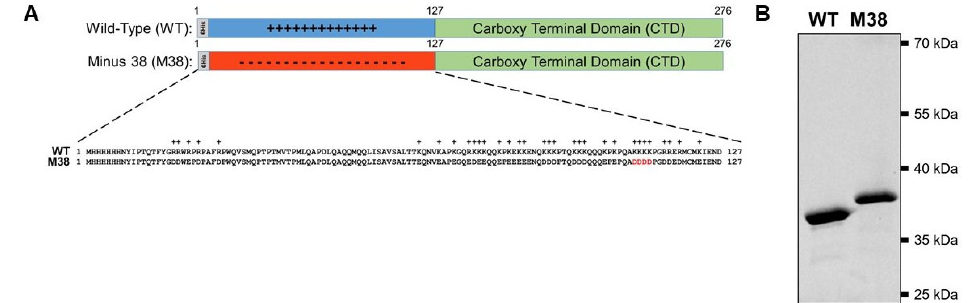
Figure 1. Ross River Virus (RRV) wild-type (WT) and Minus 38 (M38) mutant capsid proteins used to study cargo-free self-assembly. ( A ) Schematic representation of RRV WT capsid protein and M38 capsid protein. Below the schematics is the sequence of the N-terminus of each protein. The four residues in red are the four aspartates that were mutated from lysine in the 4D capsid protein. ( B ) Both WT and M38 capsid proteins can be purified in vitro. Due to their vastly di ff erent isoelectric points, the two proteins migrate di ff erently on an SDS-PAGE gel. Three micrograms of each protein was loaded on the gel and the signal detected using 2,2-trichloroethanol